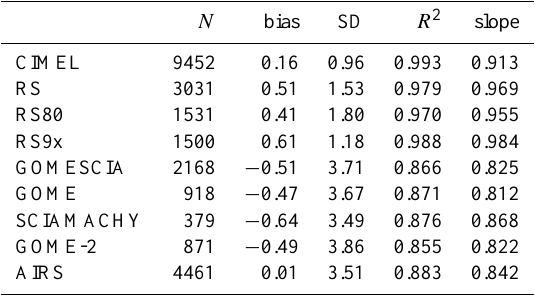
Table 5. Summary of the scatter plot properties of the IWV re- trievals for different instruments with the coincident GPS IWV re- trievals for the case study of the Brussels